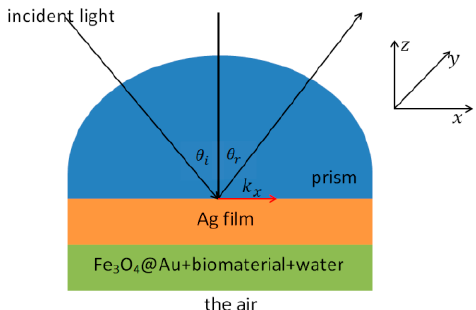
Figure 1. Kretschmann configuration for a surface plasmon resonance (SPR)-based biosensor with the inclusion of Fe 3 O 4 @Au core-shell.